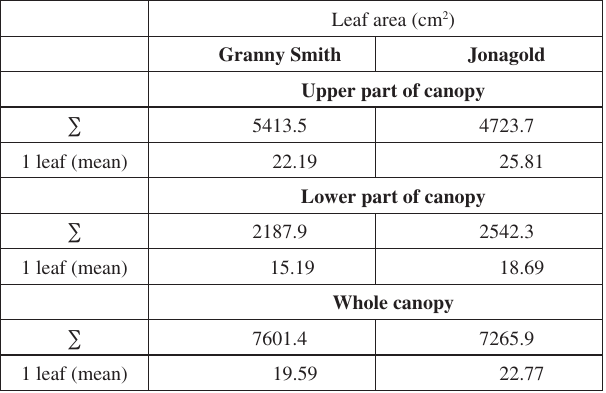
Table 4. Canopy and leaf area of Jonagold and Granny Smith apple species